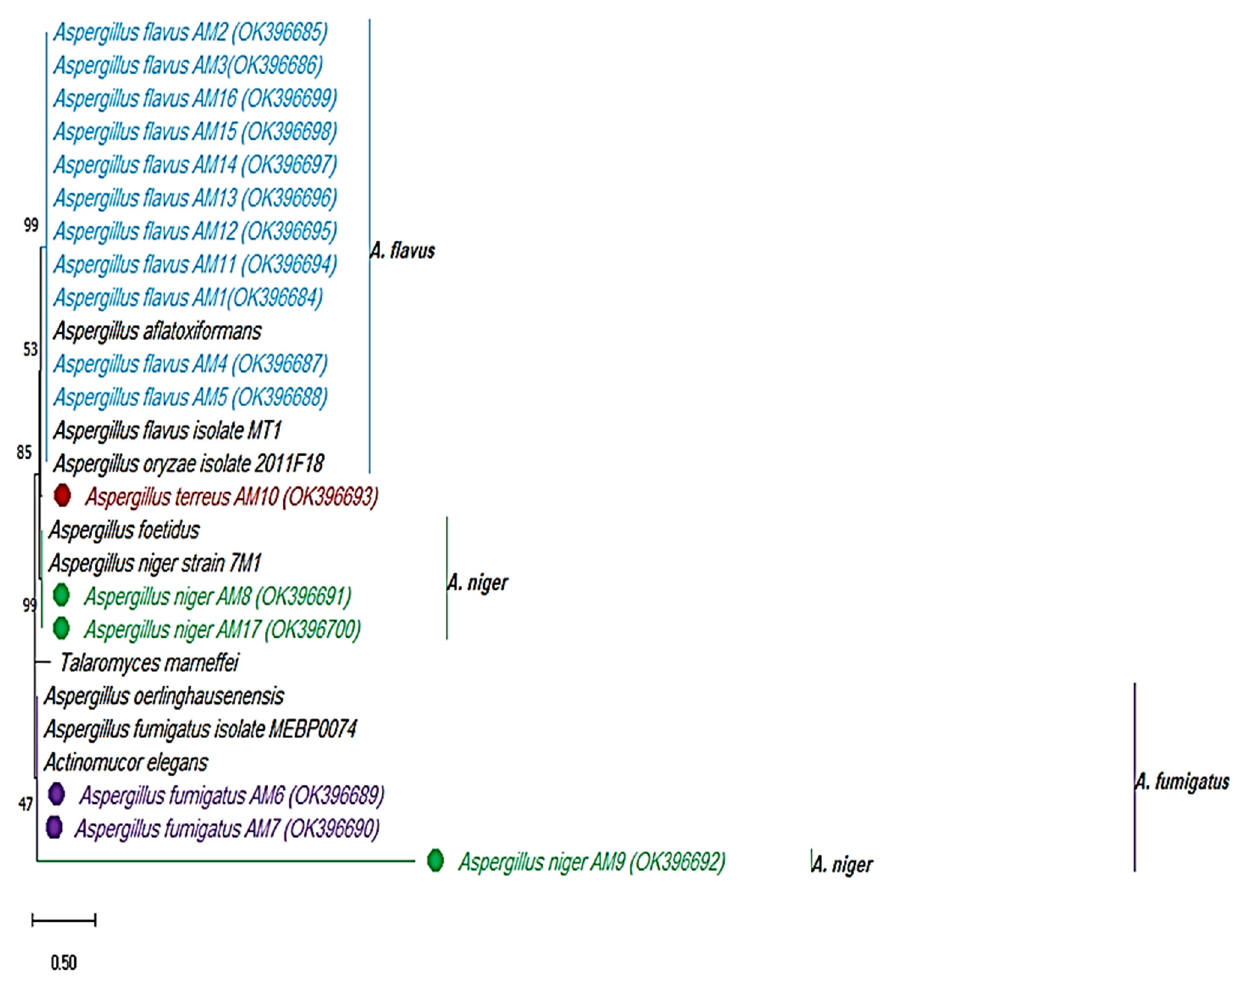
Figure 1. Identification of the clinical fungal pathogens by 18S rRNA sequencing. Maximum likelihood tree method and Tamura 3-parameter mode, 1000 bootstrapping by Mega X software. Table 1. List of fungi isolated and their NCBI accession numbers.